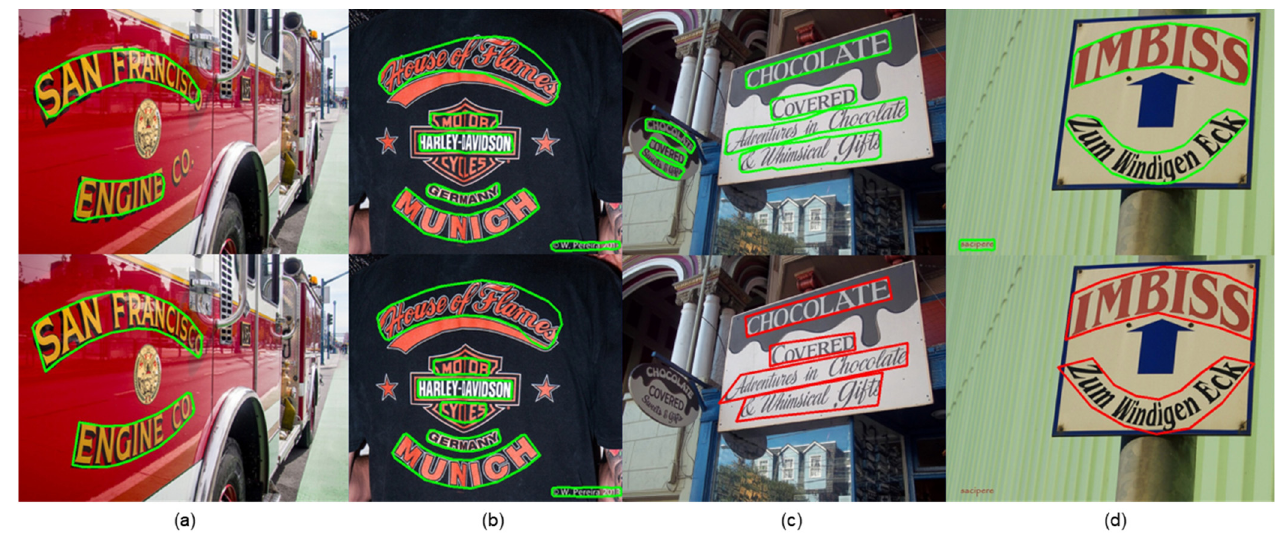
Figure 6. The visualization results ( a , b ) show the effectiveness of our model in detecting adjacent text and text with large-scale differences. Our model can separate adjacent text well during detection and detects text with large-scale differences well. ( c , d ) show that even if only coarse text annotations are provided, our model can reduce the impact of coarse annotations on learning text features, and the boundaries in the detection results fit the text edges well.